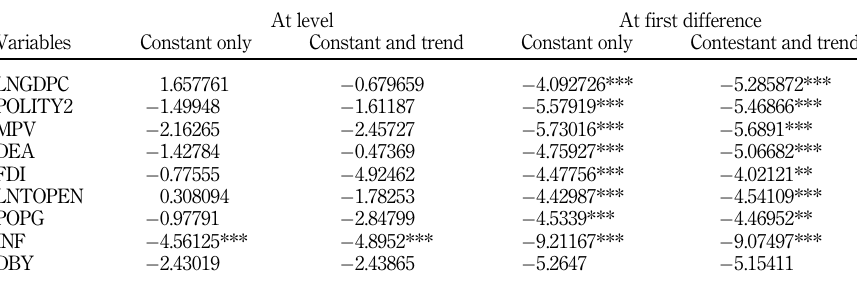
Table 3. ADF unit root test results